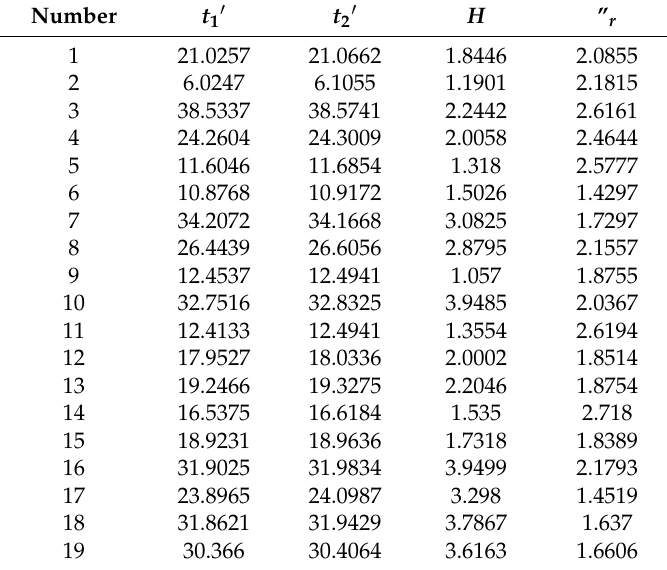
Figure 9. ( a ) The complex model; ( b ) the forward result with an offset of 1 m;and ( c ) the forward result with an offset of 2 m. Table 4. Estimated parameters of the complex test